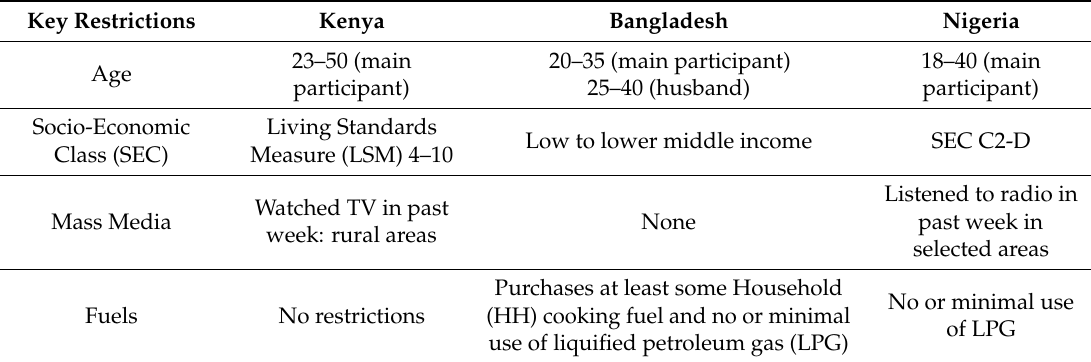
Table 2. Summary of recruitment